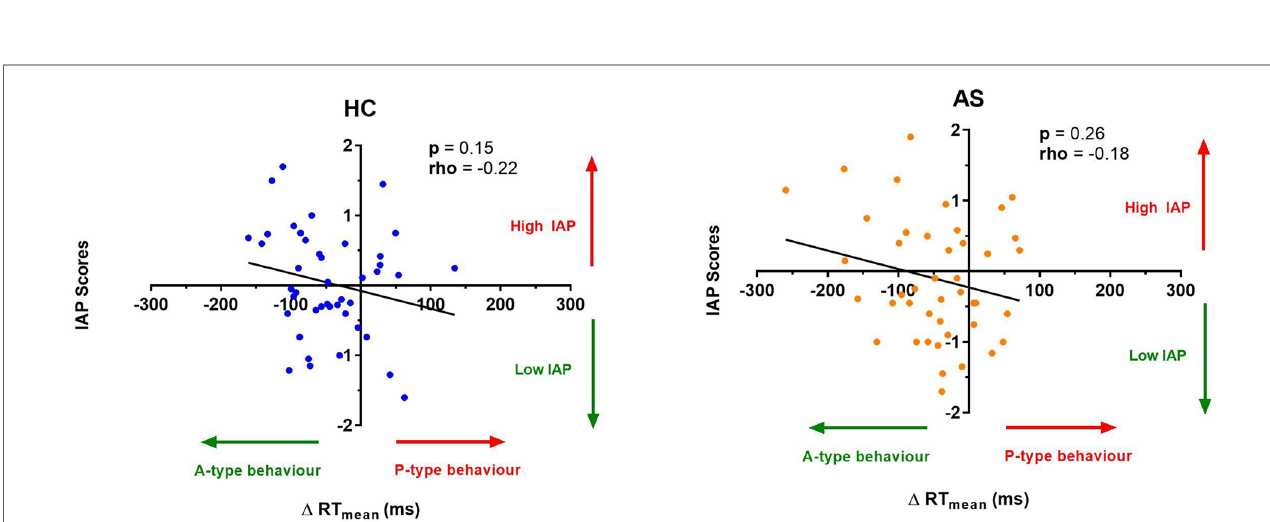
FIGURE 6 Relationship between an individual ’ s intrinsic attention to pain (IAP) and the effect of pain on task reaction time (RT). No signi fi cant correlation was found between the IAP scores and the Δ RT mean in the healthy controls (HCs) (left panel) or for the ankylosing spondylitis (AS) group (right panel). The HCs are represented by the blue dots. The AS group is represented by the orange dots. A-type behavior is represented by a negative Δ RT mean value (values that are on the left side of the horizontal axis). P -type behavior is represented by a positive Δ RT mean value (values that are on the right side of the horizontal